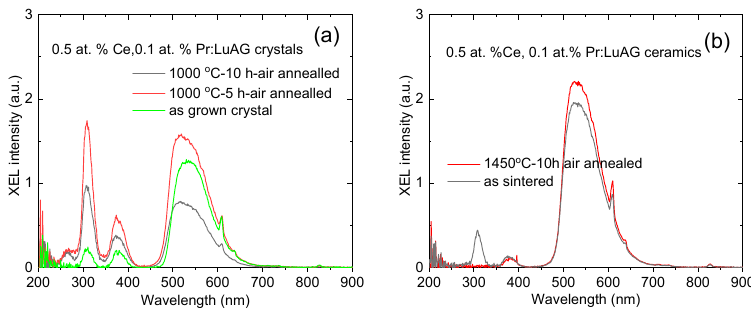
Figure 7. XEL spectra of the as grown Ce, Pr:LuAG crystals ( a ) and ceramics ( b ).